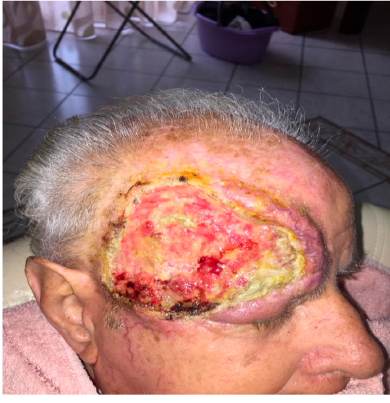
Figure 2. Patient in cancer follow-up with bloody ulcerated necrotic vegetative lesion located in the frontal-temporal skin.